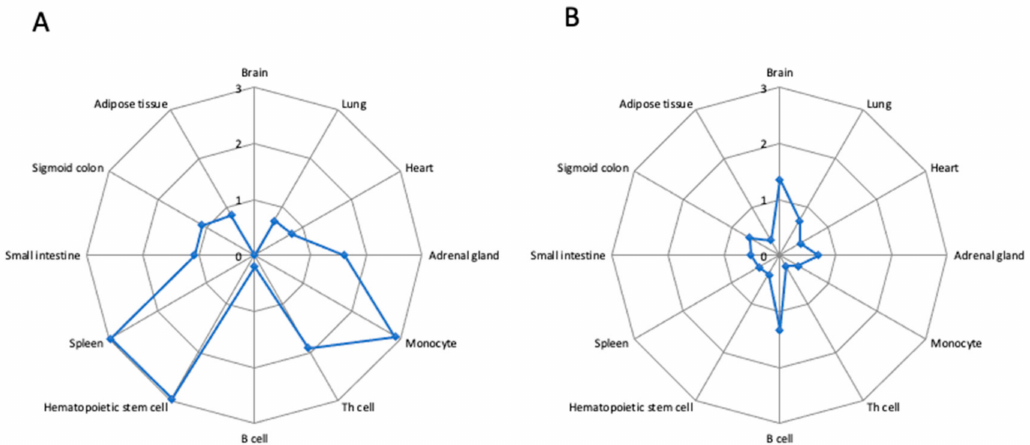
Figure 3. Sepsis-associated SNPs in super-enhancers and typical enhancers. Radar plots show the density of non-coding SNPs within super-enhancers ( A ) and typical enhancers ( B ) in 12 tissues and cell types. The SNP density (SNP/10 MB sequence) was calculated by first counting the number of SNPs within super-enhancers and typical enhancers, which was further divided by the numbers of base pairs of the super-enhancer or typical enhancer region in the same tissue or cell type, and then multiplied by 10 million. The center of the plot is 0, the SNP density (SNP/10 MB sequence) is shown on the respective axis for each tissue or cell